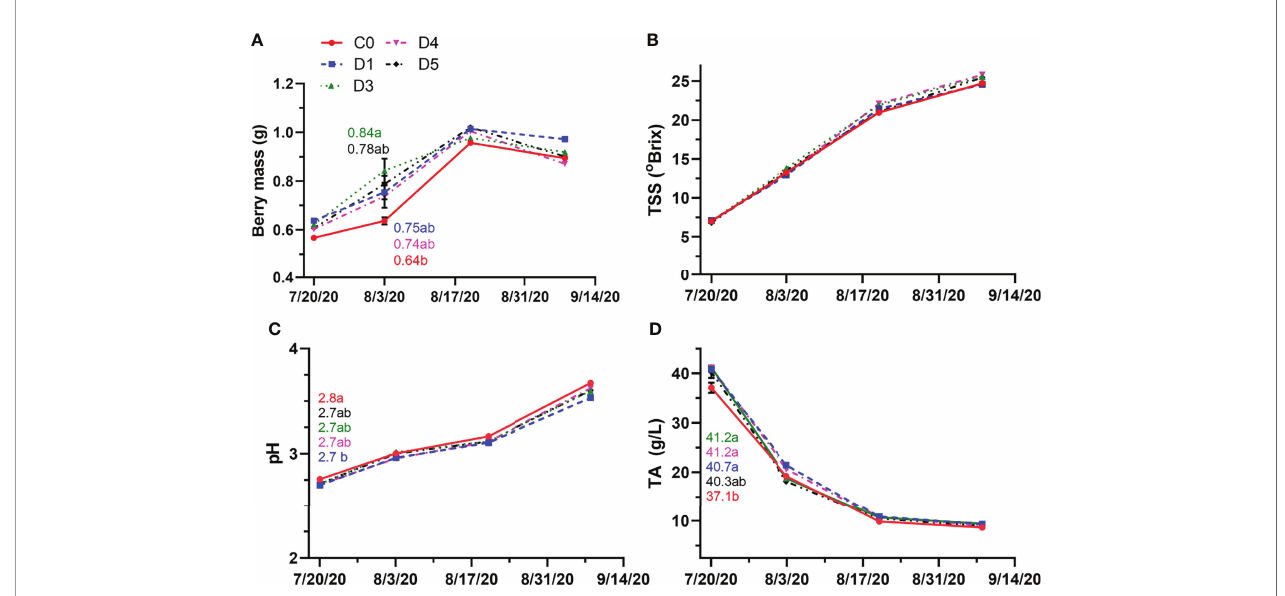
FIGURE 4 | Berry mass (A) , TSS (B) , pH (C) and TA (D) throughout berry development in 2020 for untreated (C0) and shade fi lm treatments (D1, D3, D4, D5). Points are means ± standard error ( n = 4). Means with no letters in common are signi fi cantly different (p ≤ 0.05).